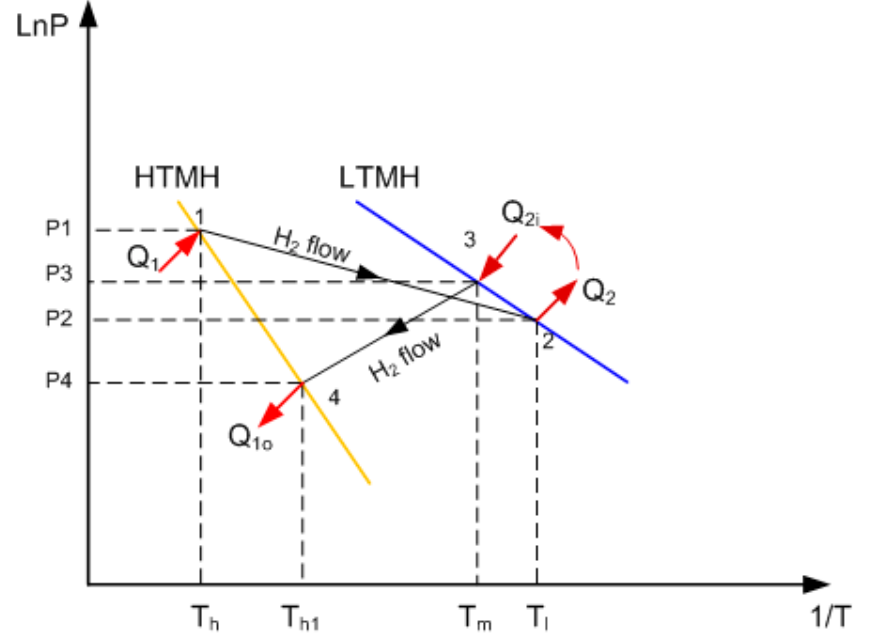
Figure 3. Working principle of the combined latent and thermochemical heat storage system: Van’t Hoff diagram.